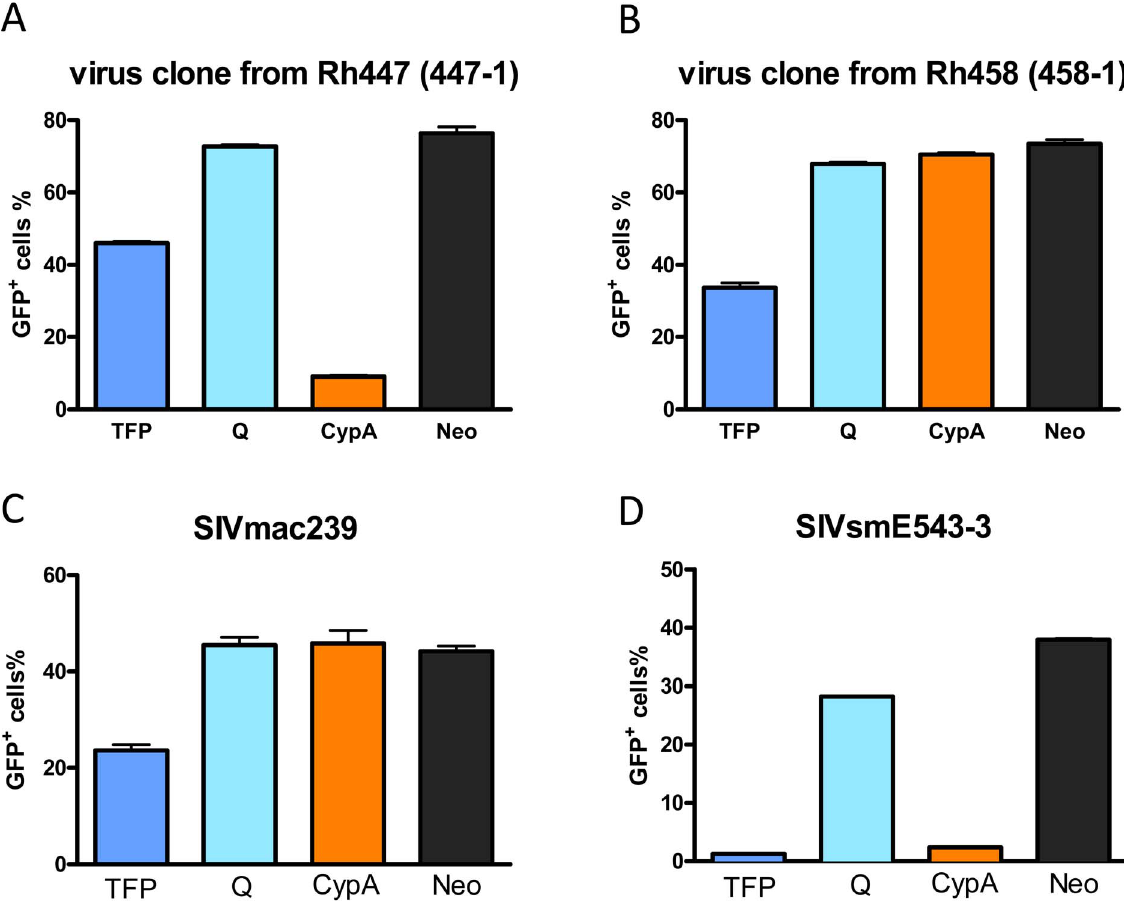
Figure 2. SIV clones from macaques with restrictive TRIM5 alleles overcame restriction at later stage of infection. Single-cycle infectivity of SIV clones from Rh447 (A, TRIM5 TFP/TFP ) and Rh458 (B, TRIM5 TFP/CypA ) was measured on a panel of cell lines stably expressing the rhesus TRIM5 TFP allele (dark blue bars), TRIM5 Q allele (light blue bars) and TRIM5 CypA (orange bars). Infectivity was measured as percent GFP positive cells. Black bars are negative vector controls. SIV clones SIVmac239 (C) and SIVsmE543-3 (D) were used as